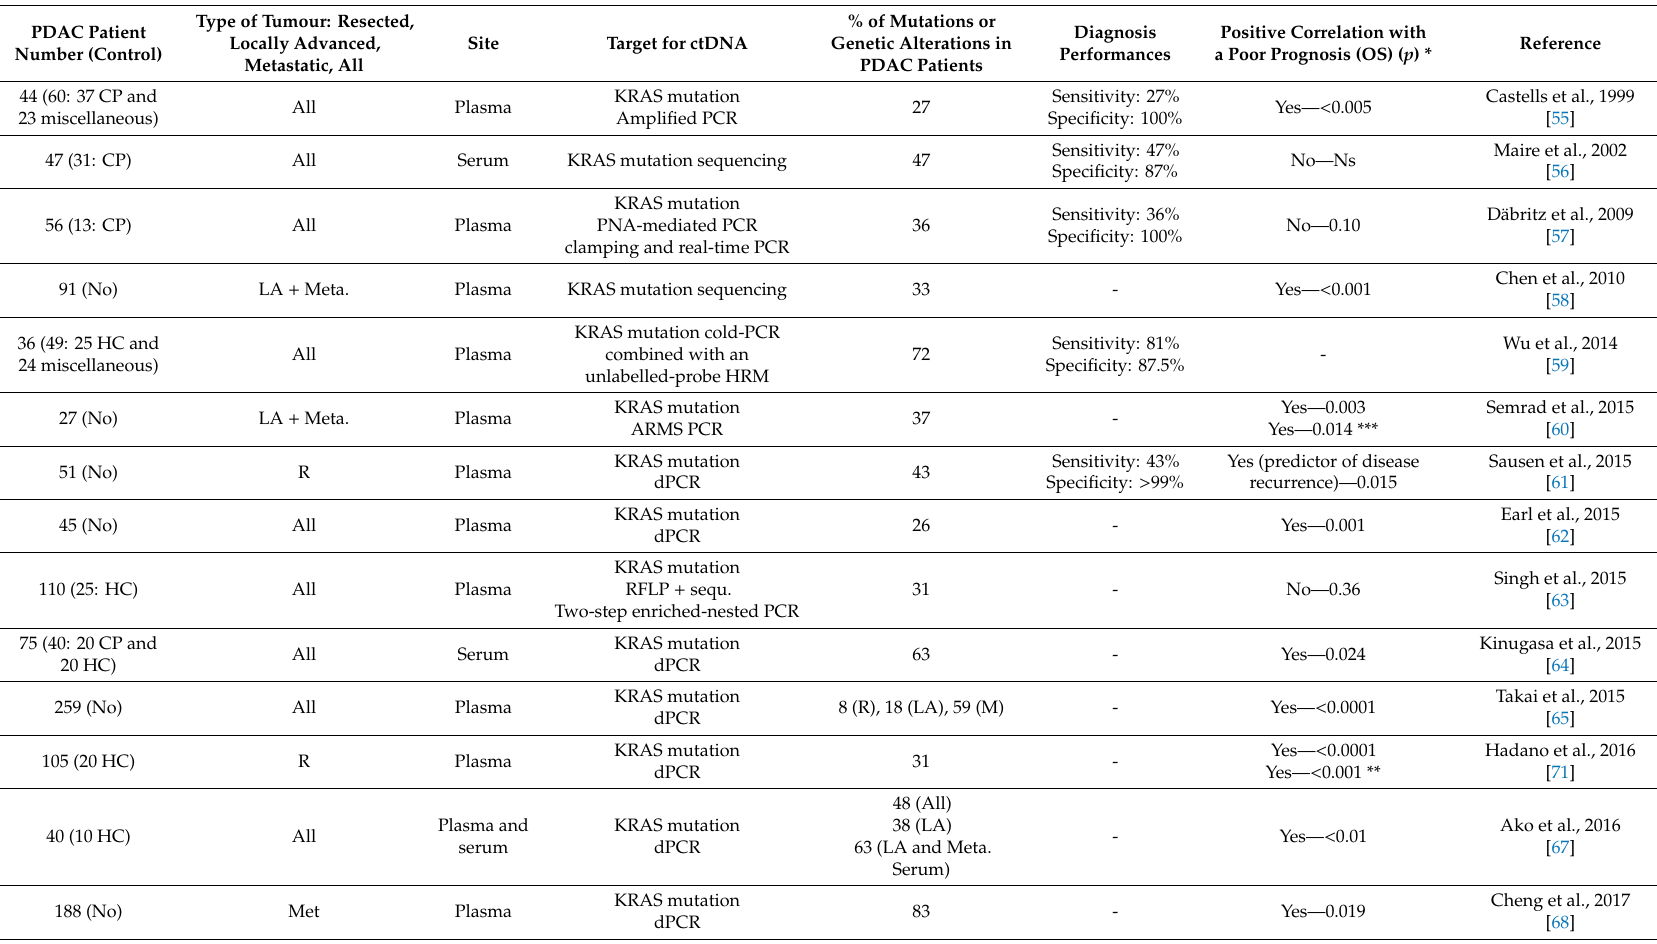
Table 2. The main studies that have investigated the role of ctDNA in the diagnosis and / or prognosis of pancreatic ductal